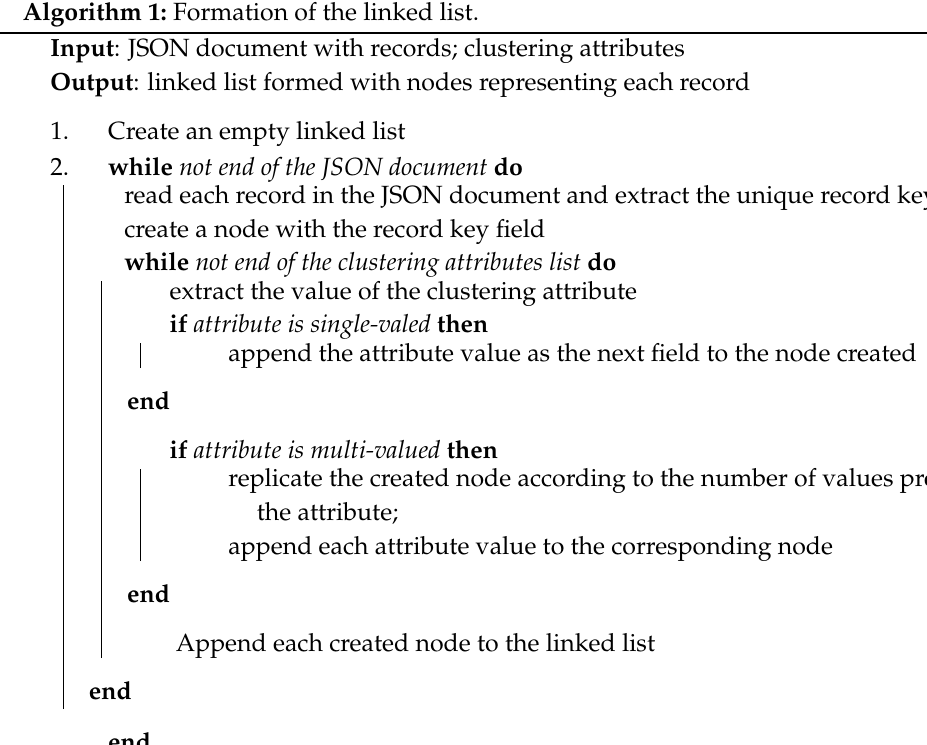
Algorithm 1: Formation of the linked list.